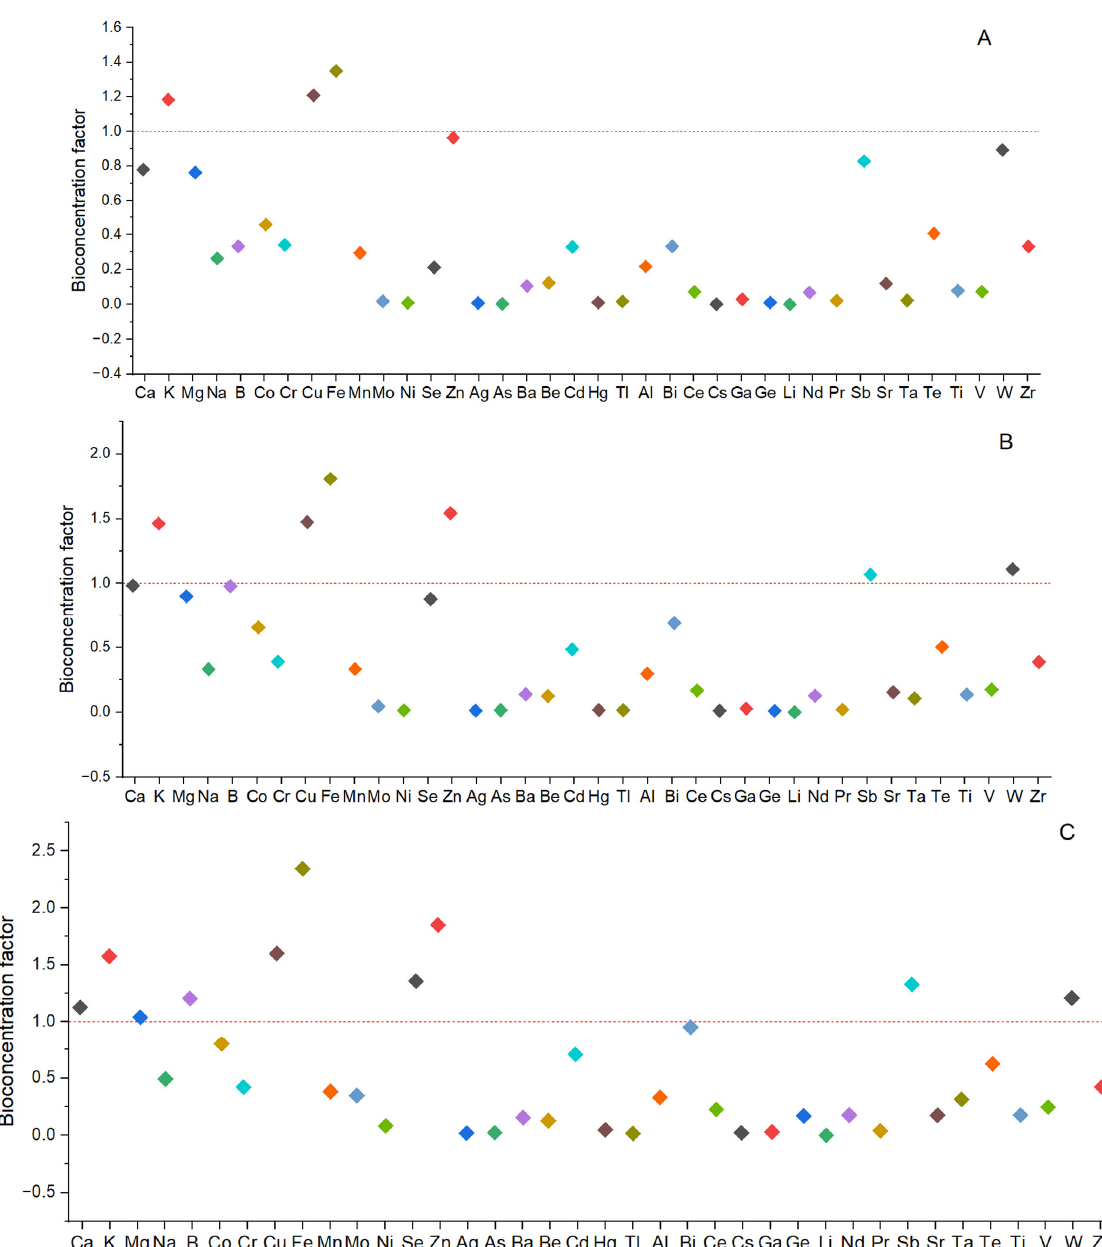
Figure 1. Scatterplot illustrating bioconcentration factor (BCF) from flush I ( A ), flush II ( B ) and flush III ( C ) of major essential elements (MEEs): Ca, K, Mg, Na; essential trace elements (ETEs): B, Co, Cu, Cr, Fe, Mn, Mo, Ni, Se, Zn; trace elements with detrimental health effect (TEWDHE): Ag, As, Ba, Be, Cd, Hg, Tl; nutritionally nonessential elements (NNEs): Al, Bi, Ce, Cs, Ga, Ge, Li, Nd, Pr, Sb, Sr, Ta, Te, Ti, V, W, Zr in P. djamor mushroom fruiting bodies cultivated on EMS. The red-dotted lines represent a reference line for BCF (marked at 1.00), the presented BCF values for elements in respective graphs below the line are less than 1.00 and above the reference line are greater than 1.00. The scatterplots for BCF were generated using the OriginLab 2021 software for Windows (OriginLab Corp., Northampton, MA, USA).